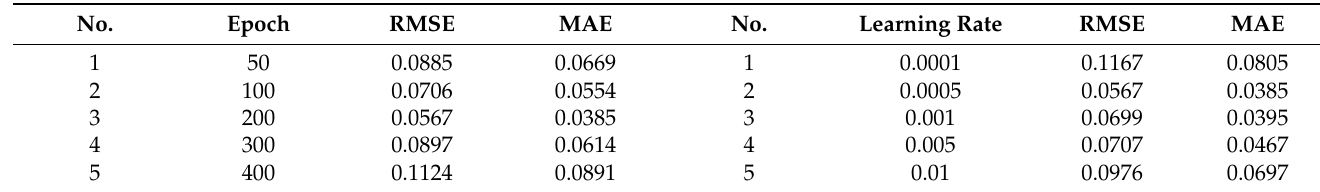
Table 3. Results of the proposed method with different epochs and learning rates.